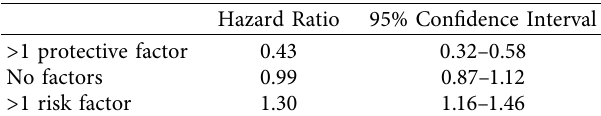
Figure 6: Kaplan–Meier survival function over time for 1-year survivor pediatric liver transplant recipients by recipient transplant history. Table 3: Multivariable cox regression for risk stratification groups: Hazard ratios for mortality.